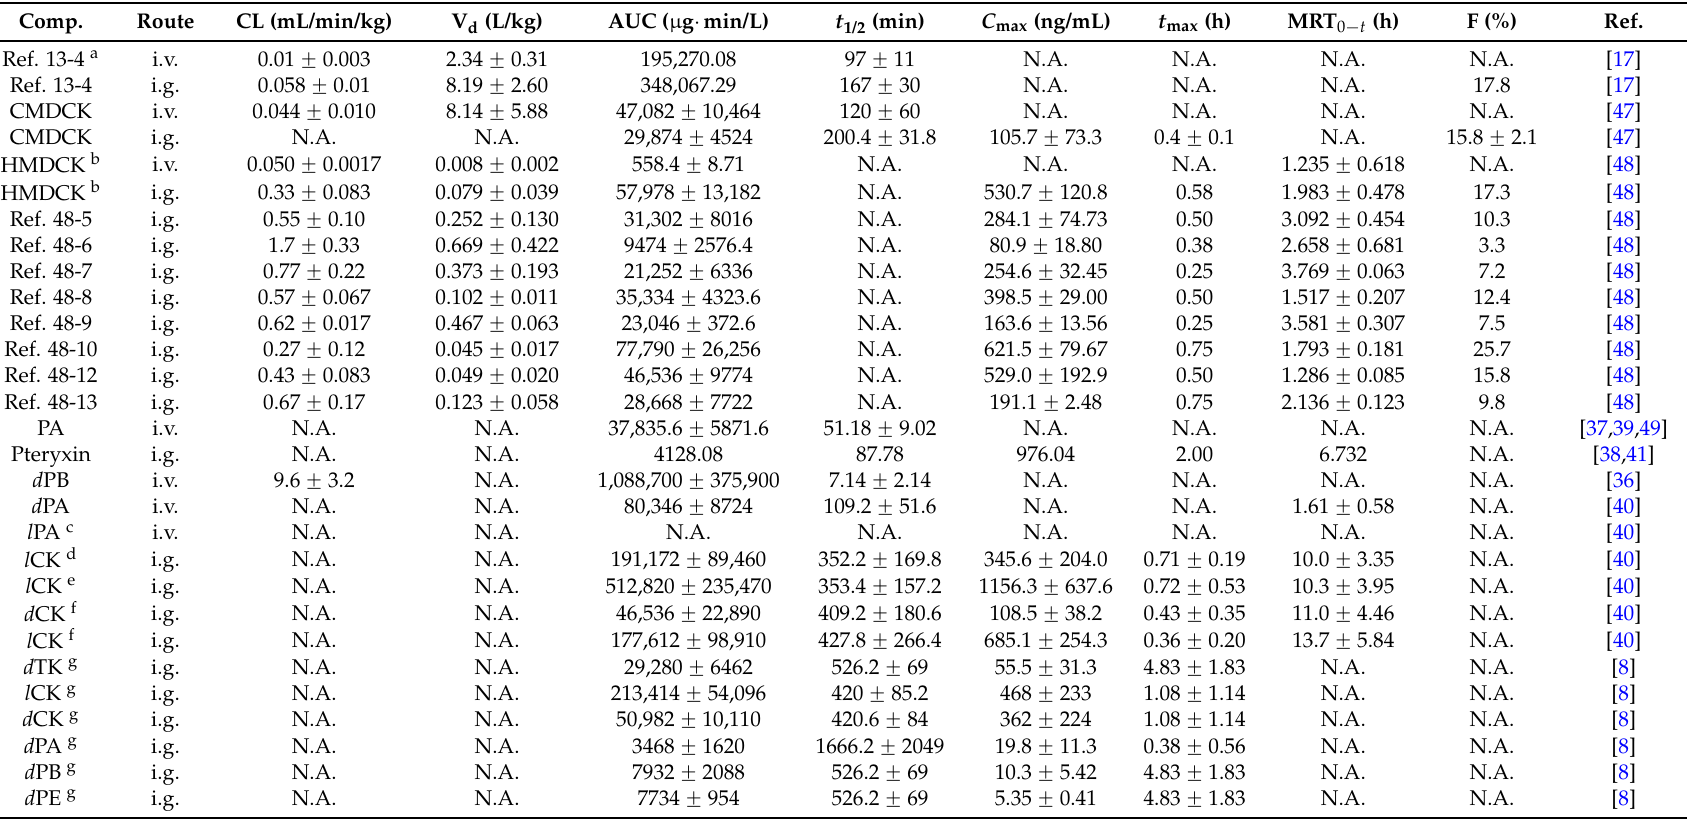
Table 1. Pharmacokinetic parameters of khellactone derivatives in vivo